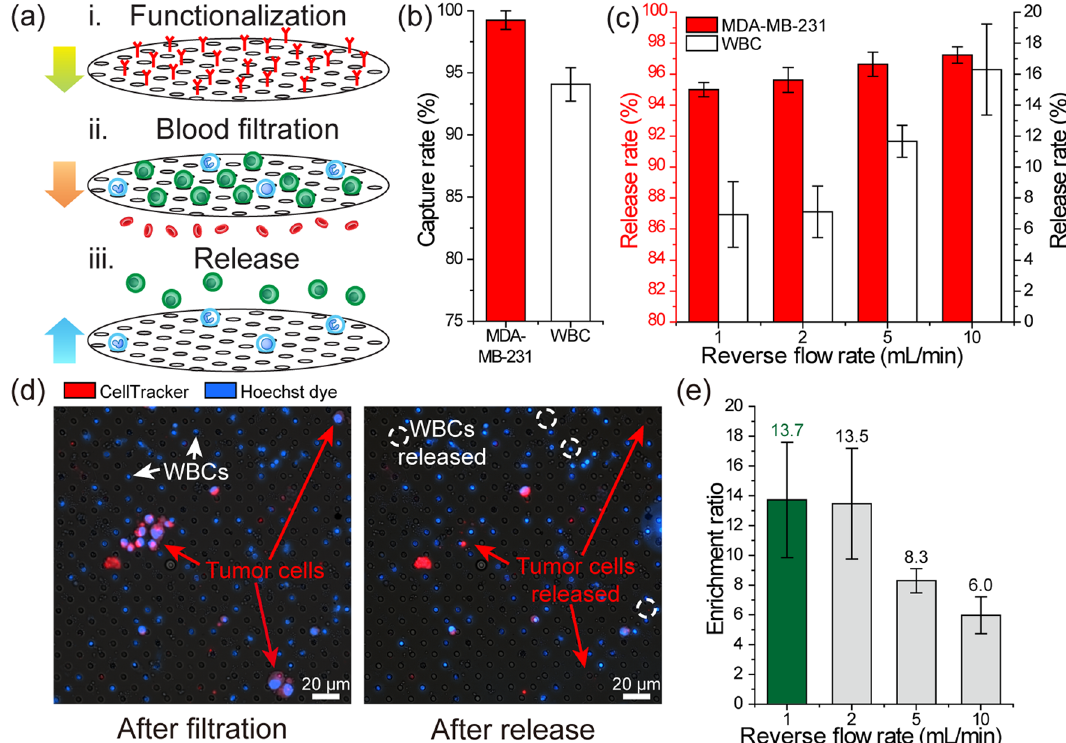
Figure 2. Characterization of the immuno-functionalized PDMS membrane filter for tumor cell enrichment. ( a ) A schematic showing the tumor cell enrichment process. Following the immuno-functionalization of the membrane filter, whole blood spiked with MDA-MB-231 tumor cells is driven through the filter to capture nucleated cells on the filter and discard anucleated cells. The mechanically retained tumor cells are then released from the membrane filter under reverse flow. ( b ) Measured capture rates of the MDA-MB-231 tumor cells and WBCs during filtration (n = 3). ( c ) Measured release rates of the (left axis) MDA-MB-231 tumor cells and (right axis) WBCs under different reverse flow rates (n = 3). ( d ) Fluorescence microscope images of the PDMS membrane filter (left) right after the filtration of the blood sample and (right) following the release of cells under reverse flow. The images show that the tumor cells were succesfully released from the filter while most of the immunocaptured WBCs were retained on the filter with the reverse flow. ( e ) Calculated average enrichment ratio for the spiked tumor cells as a function of different reverse flow